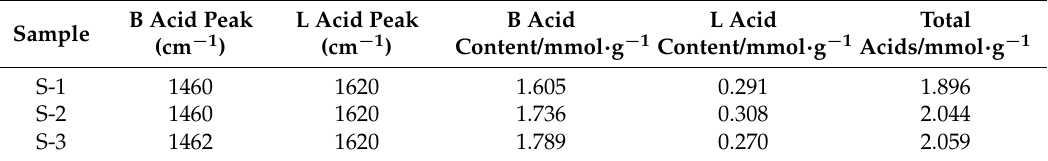
Table 6. The element composition and relative crystallinity of the sample with different templates.